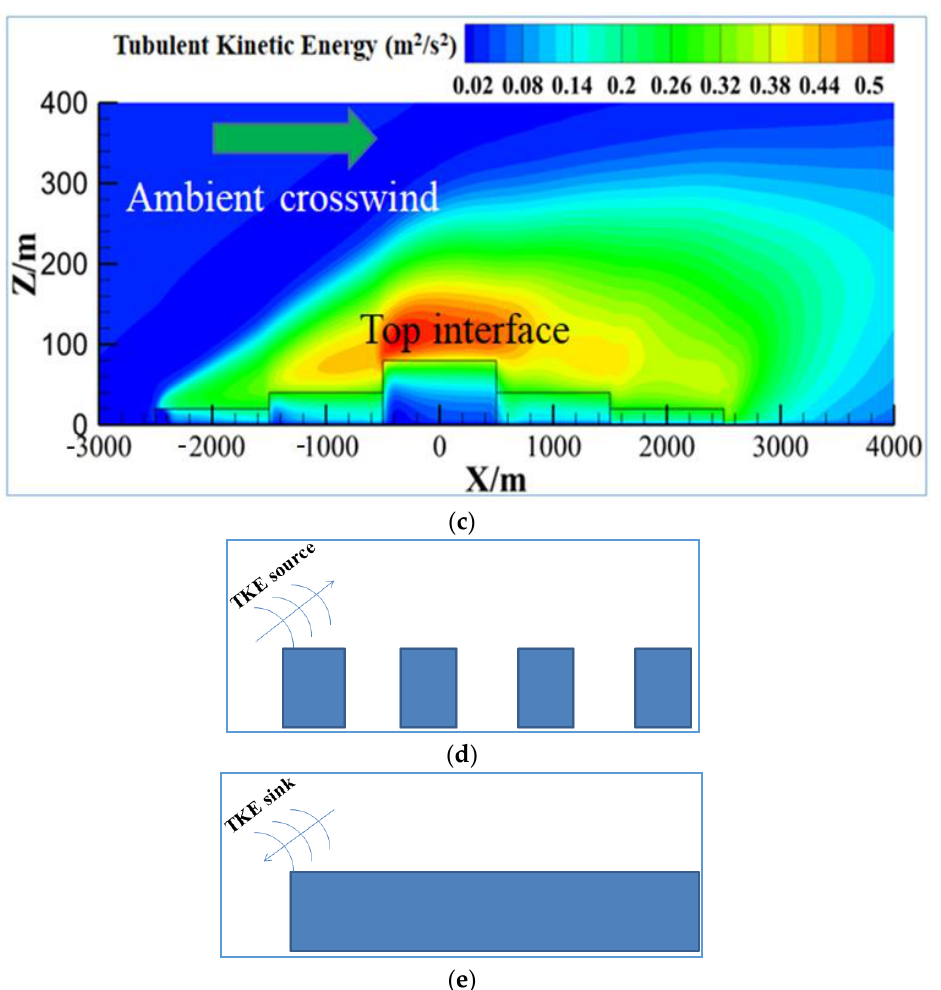
Figure 8. Distribution of ( a ) horizontal velocity, ( b ) vertical velocity, ( c ) TKE, ( d ) TEK microscale simulation results (building zone), ( e ) TEK macroscale simulation results (porous medium zone) in plane y = 0 when the wind speed is 2 m/s.